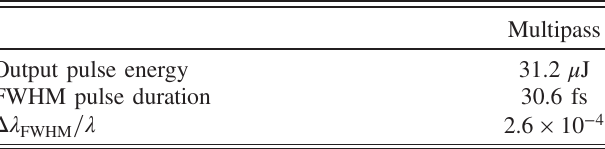
TABLE IV. Properties of 2.5 nm FEL output radiation. For the multipass HOK resonator-radiator simulations starting from shot noise, the pulse energy, the FWHM pulse duration, and the relative FWHM bandwidth are the average ones in the steady- state regime of the